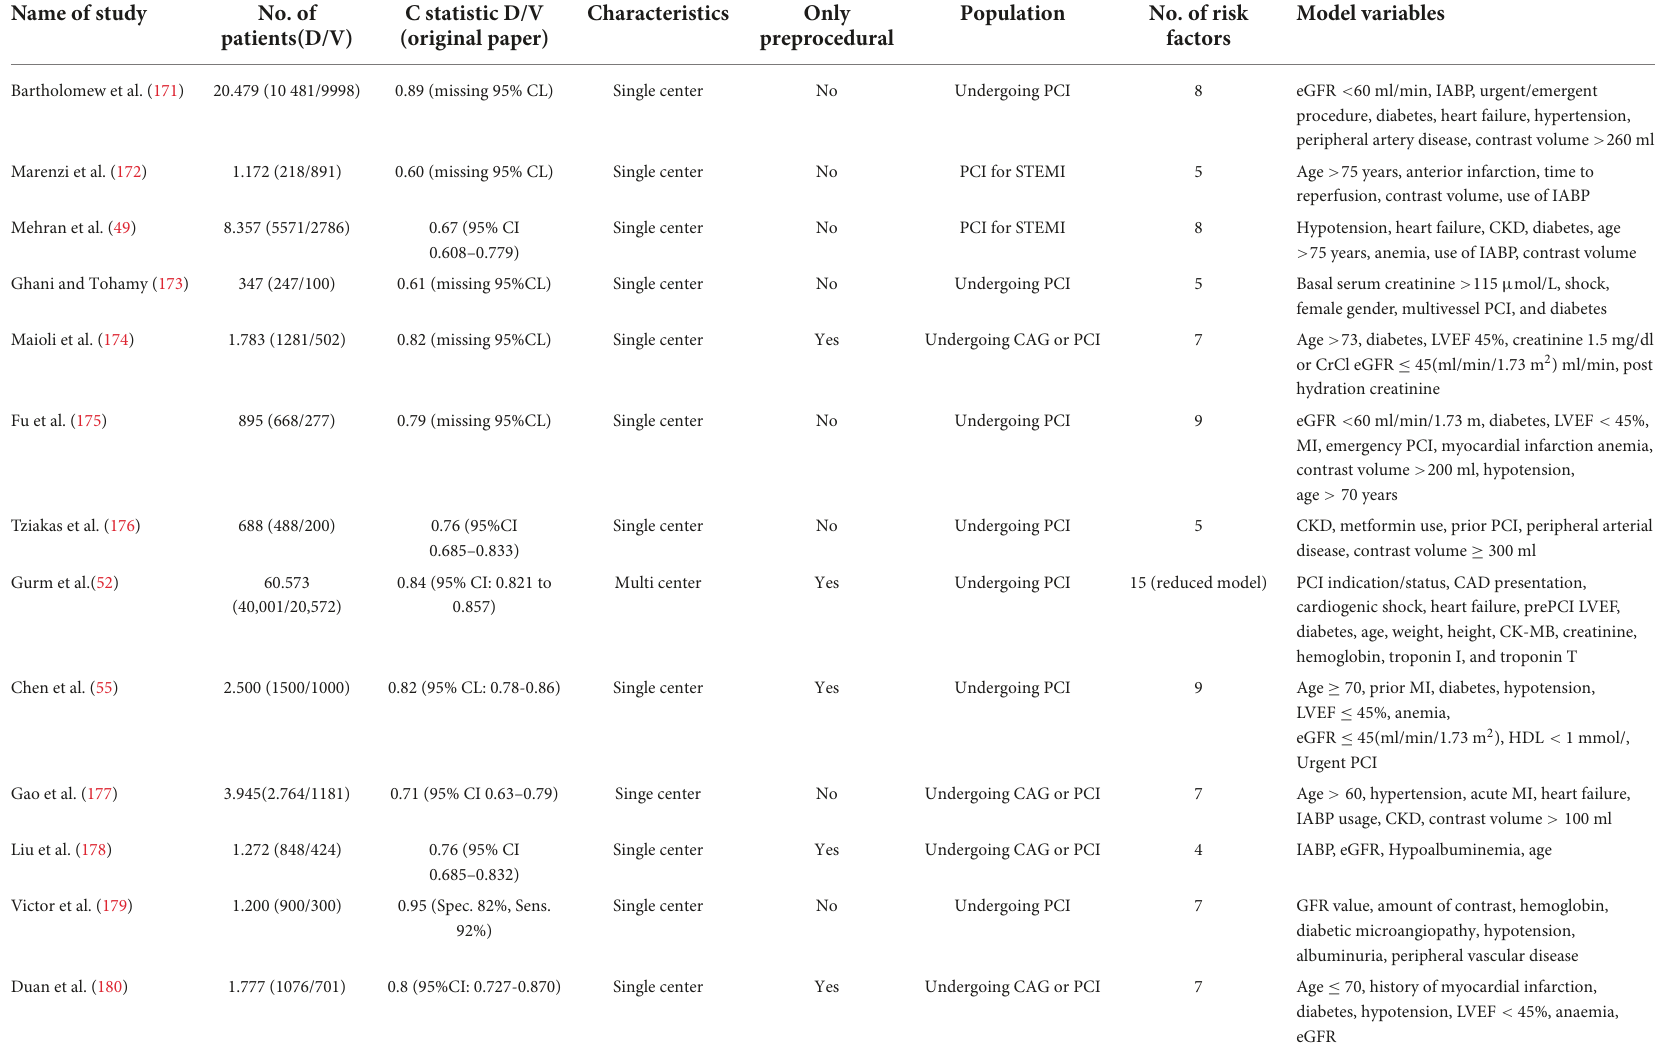
TABLE 2 Risk stratification